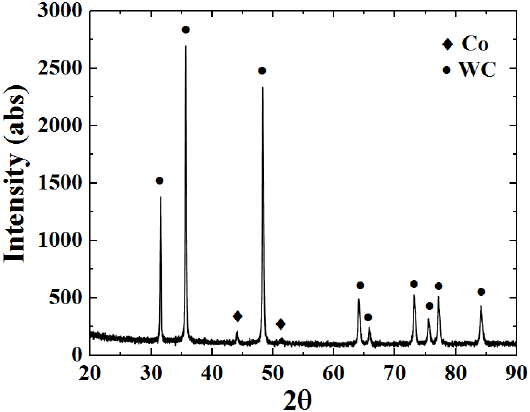
Figure 9. The XRD phase pattern of the WC-12Co powder.